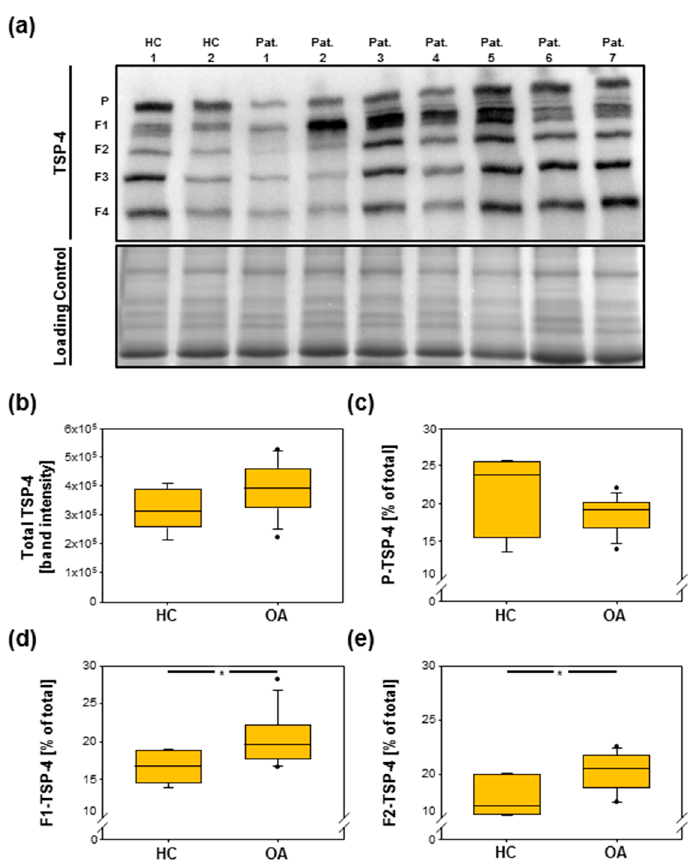
Figure 5. Detection of TSP-4 in sera of healthy donors and OA patients. ( a ) The immunoblot analysis of sera shows the pentameric TSP-4 and derived fragments (1–4). Equal loading was demonstrated via PageBlue TM staining (loading control). Amounts of total ( b ) as well as of pentameric TSP-4 ( c ) are not significantly different between HCs and OA, but a significant increase of fragment 1 ( d ) and fragment 2 ( e ) could be detected in OA patients. Immunoblot was shown as representative blot. Values are represented as box blots and significance ( p < 0.05 *) was analyzed by the Mann–Whitney U test. Dots in figures b-e represent outliers. HC = healthy controls; Pat. = patient; OA = osteoarthritis; P = pentamer, F = fragment.